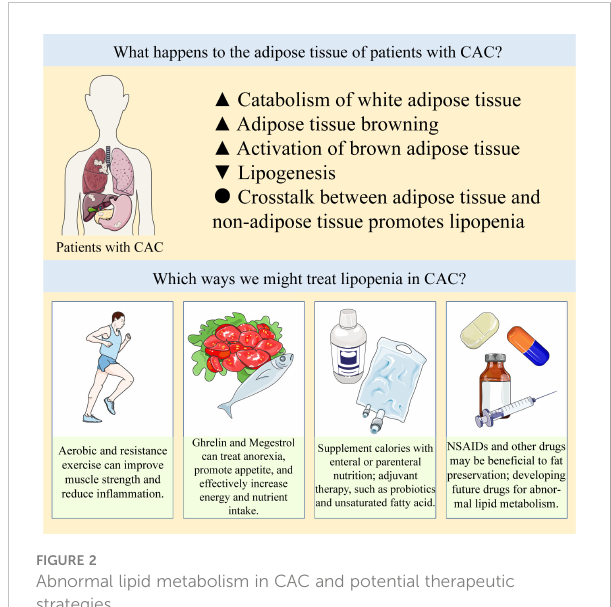
FIGURE 2 Abnormal lipid metabolism in CAC and potential therapeutic